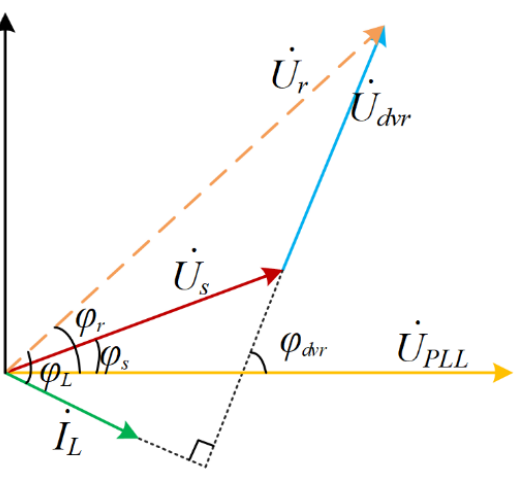
Figure 4. Phasor diagram of the energy minimized compensation.